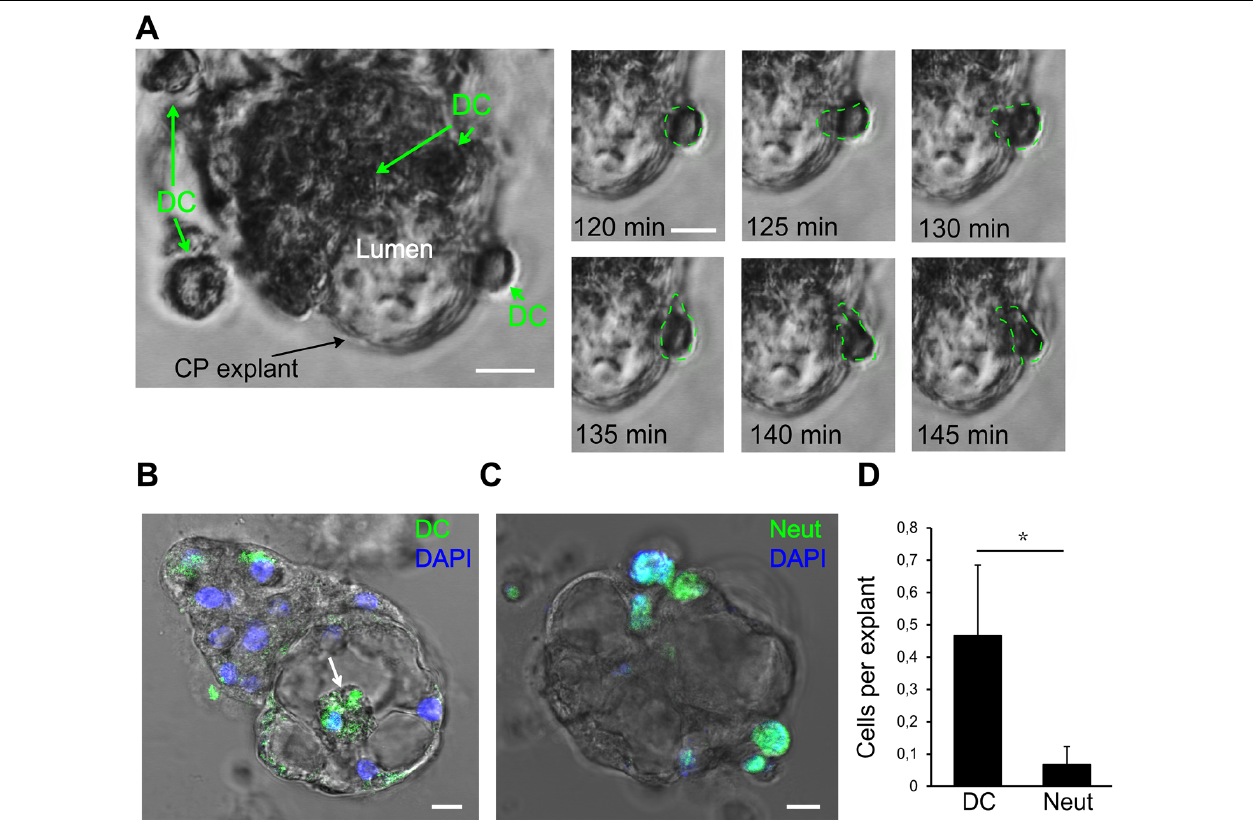
FIGURE 6 | Interaction of human dendritic cells (DCs) with CP epithelium. (A) A representative migration experiment with human DCs interacting with the CP explant (bar 10 µ m). Time series shows one of the DCs crossing into the lumen space. The last 35 min of the total of 100 min of the experiment are shown. (B) Human DCs labeled with CFSE (green) migrate into the lumen (white arrow). Endpoint image after the experiment. (C) Mouse neutrophils (MN) labeled with CFSE (Neut, green arrows) attached to CP explant. (D) Comparison of DC and neutrophil (Neut) transmigration into the explant lumen during 24 h. Data are means ± SEM. * p < 0.05 by Wilcoxon rank-sum test, n =